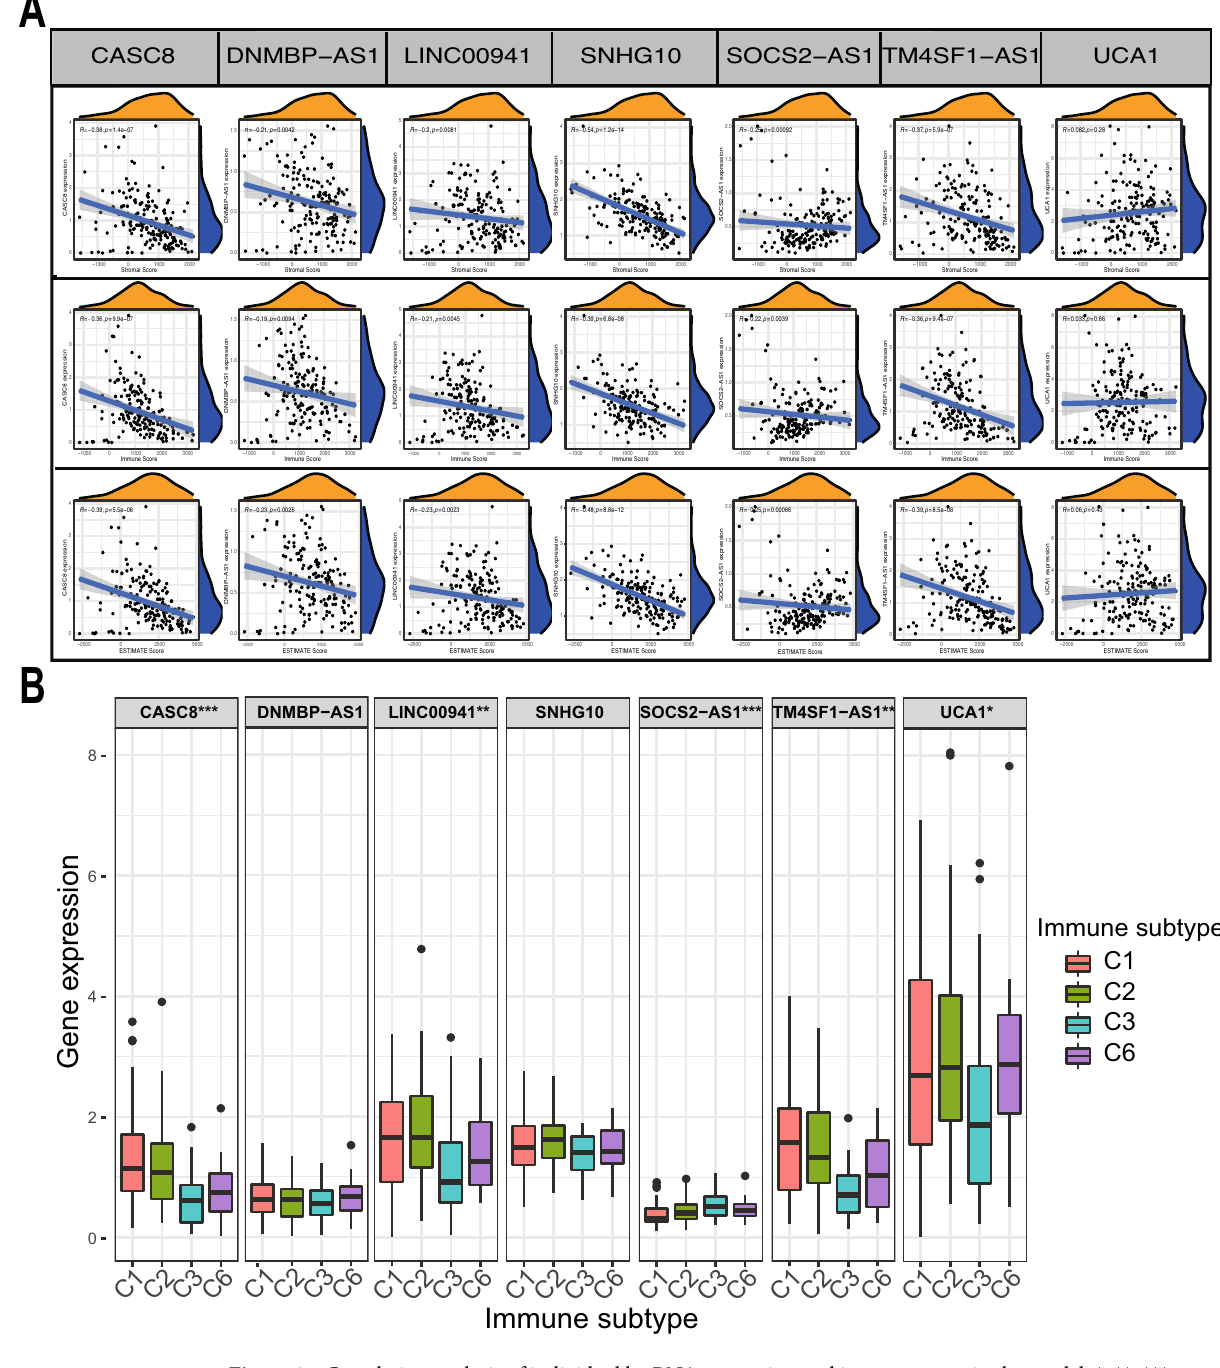
Figure 8. Correlation analysis of individual lncRNA expression and immune score in the model. *, **, ***, represent P < 0.05, P < 0.01 and P < 0.001. ( A ) Correlations between lncRNA expression and immune infiltration score. ( B ) Relationship between lncRNA expression and immune